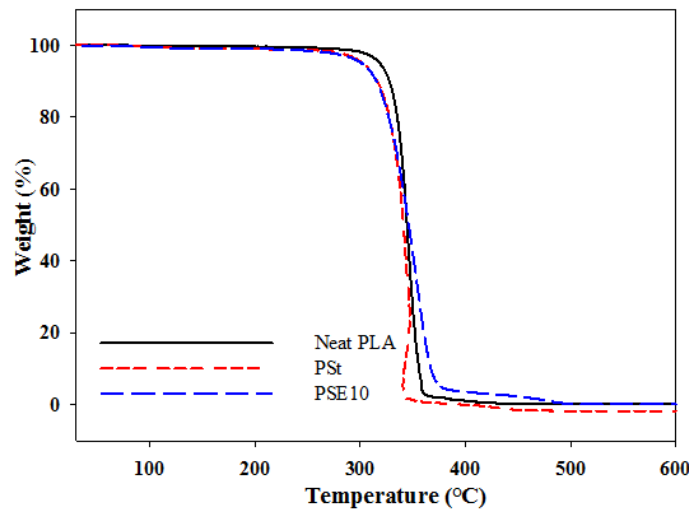
Figure 2. Thermogravimetric (TGA) thermograms of neat PLA, PSt, and PSE10. Table 3. Thermal degradation temperatures of neat PLA, PSt, and PSE10.